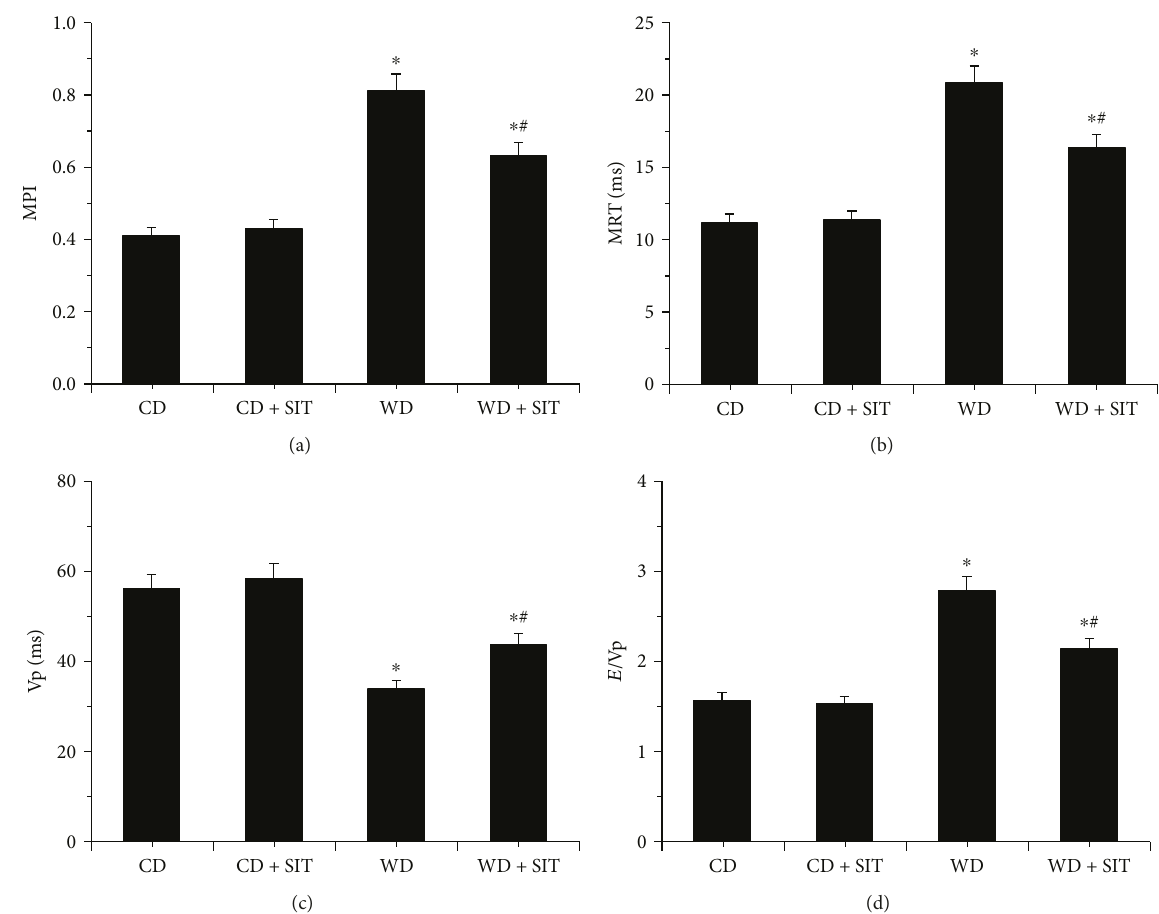
Figure 2: Echocardiographic assessment of cardiac function was evaluated at the end of treatment. WD induces diastolic dysfunction in WD mice. Bar graphs show (a) MPI, (b) isovolumic relaxation time (IVRT), (c) Vp, and (d) E /Vp ratio, an index of LV fi lling pressure. Values are means ± SE. ∗ P < 0 05 compared to CD at the end of experiment; # P < 0 05 compared to WD at the end of